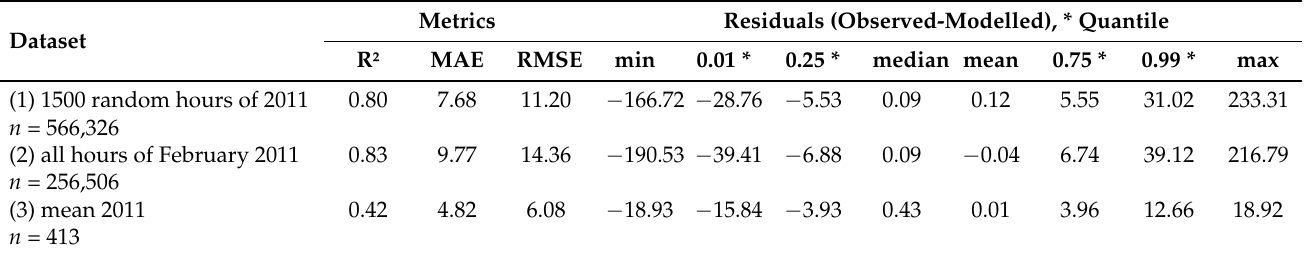
Table 3. Results of the leave-one-out cross-validation (loo-cv) for the different datasets used (MAE, RMSE, and residuals in µgm − 3 ).